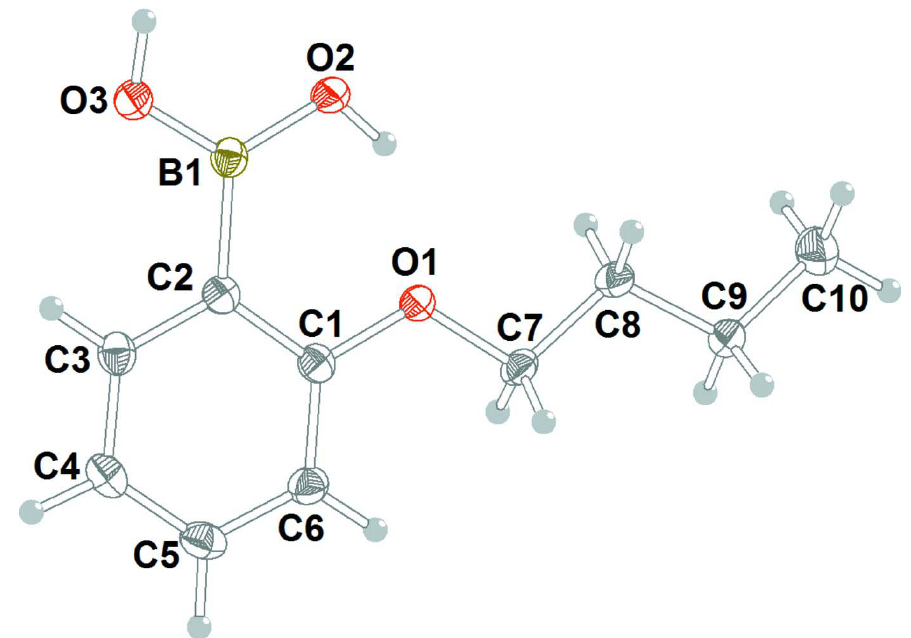
Figure 1 The molecular structure of (I). Displacement ellipsoids are drawn at the 50% probability level.